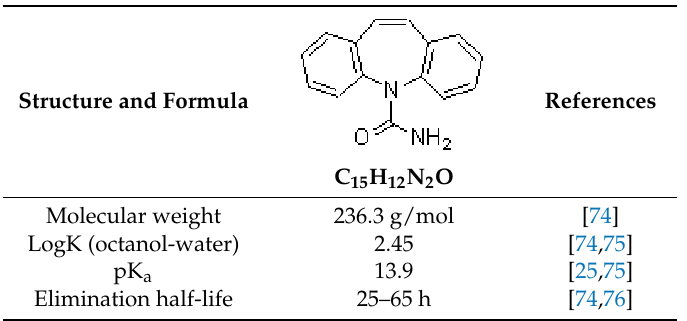
Table 5. Main physicochemical properties of CBZ.